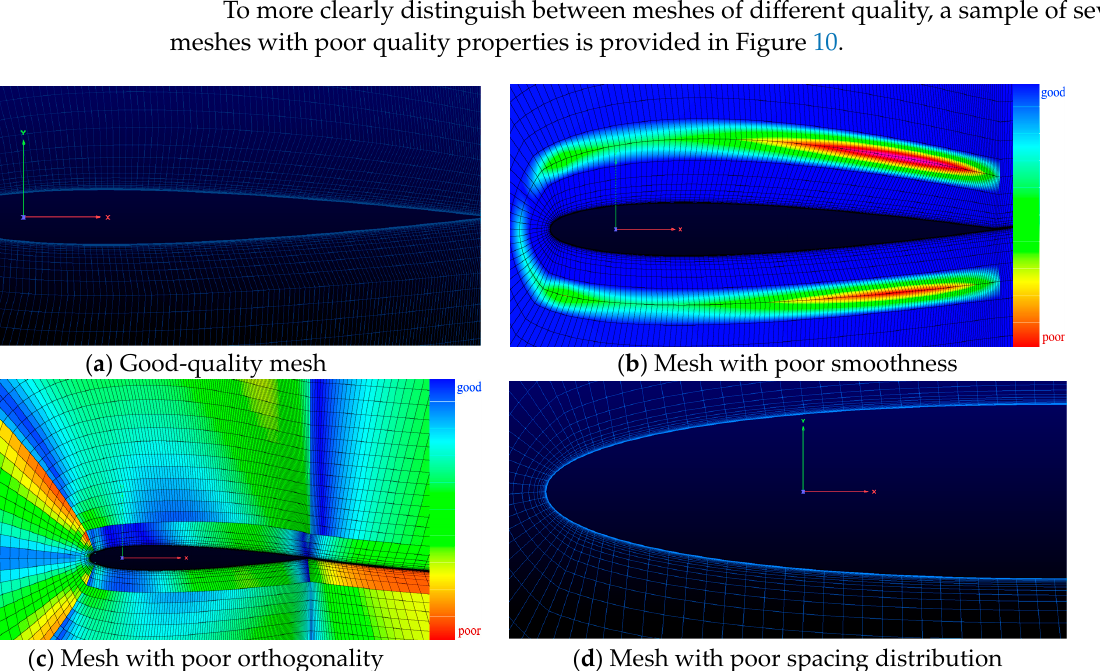
Figure 10. Airfoil mesh samples generated in the NACA-Market dataset. ( a ) A good-quality mesh; ( b ) a mesh with poor smoothness (the smoothness is represented by a color bar); ( c ) a mesh with poor orthogonality (the orthogonality is represented by a color bar); ( d ) a mesh with poor spacing distribution (inappropriate mesh spacing in the boundary